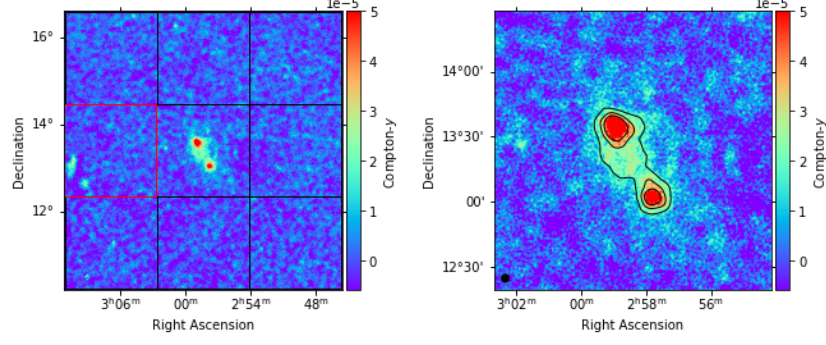
Figure 1. Left : ACT Compton- y map of A399-401. The seven external black boxes enclose the regions we used to estimate the covariance matrix. The region surrounded by the red box has been excluded due to dust contamination. Right : Central region of the ACT map. It is the region we fitted with the MCMC in Sec. 3. Contour levels are 3, 5, and 7 σ . The e ↵ ective beam of the map is showed on the bottom left side as a black circle with a radius equal to half